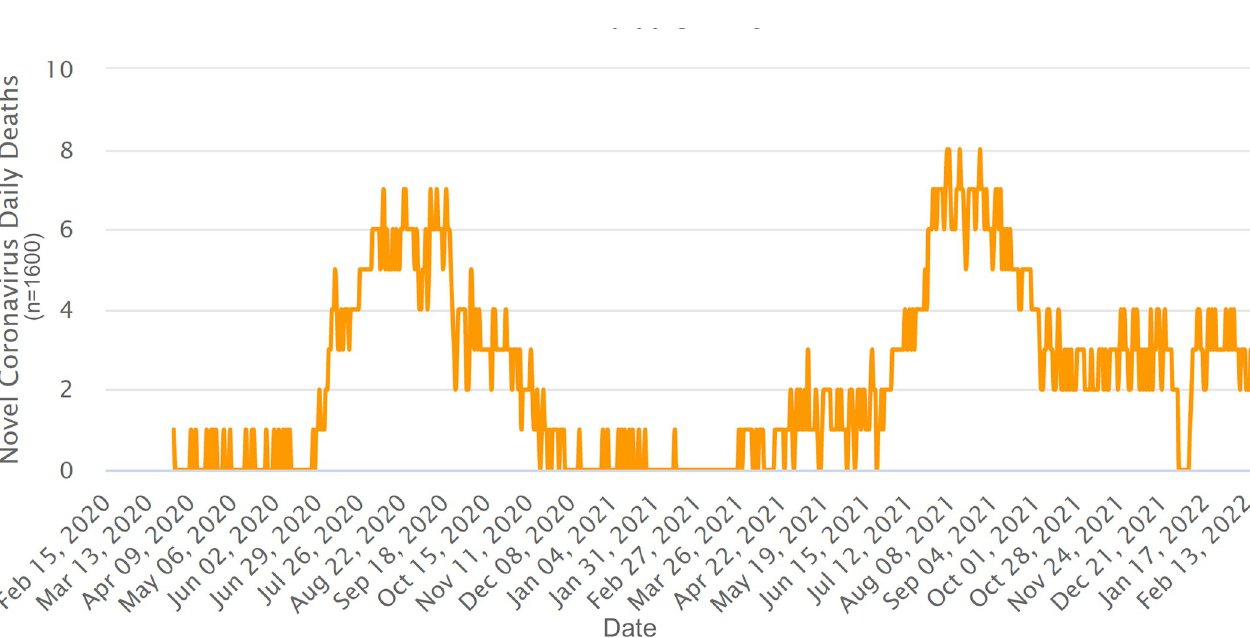
PLOS ONE | https://doi.org/10.1371/journal.pone.0270314 June 27,